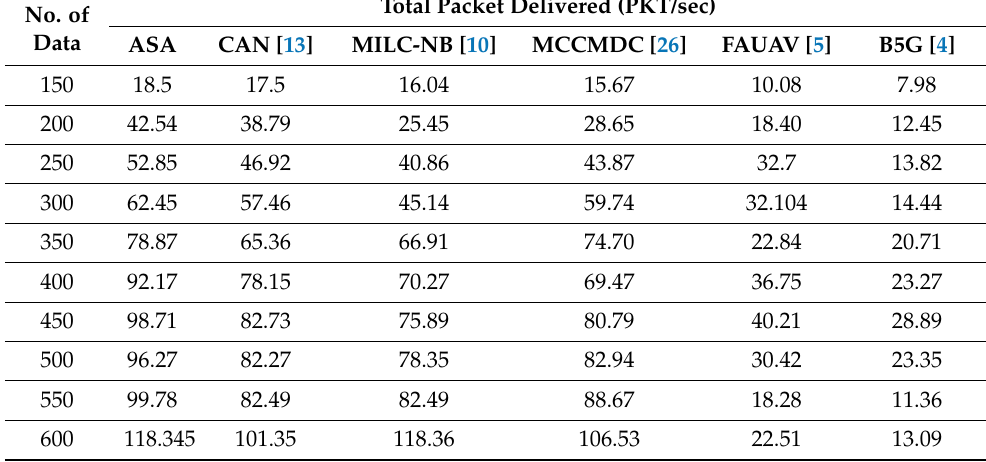
Table 1. Analysis of Total packet delivered